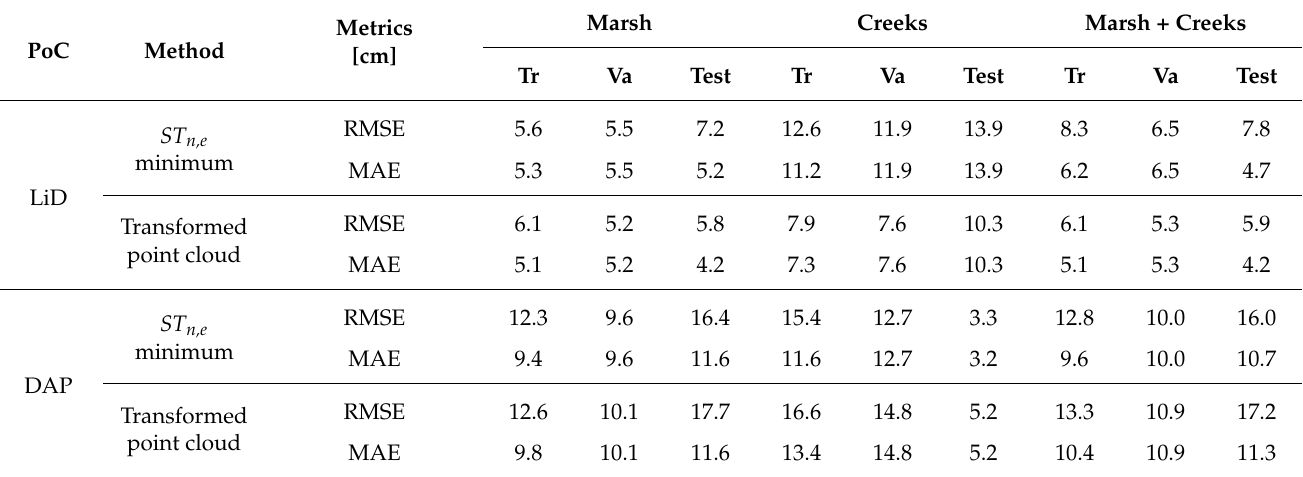
Table 2. The errors we obtained for the training (Tr), validation (Va), and Test phases of the LOOCV procedure we performed to validate the linear regression between surveyed and computed ground elevations. Groud elevation is computed from the LiDAR- (LiD) and the Digital Aerial Photogrammetry (DAP)-UAV point clouds (PoC) in ST n,e as: (i) the minimum elevation of the non-transformed point clouds; (ii) the minimum elevation of the point clouds transformed using a regression plane. Results are displayed for the regression in Equation (9) using the data collected in the marshes, creeks, and both. The errors are reported in centimeters.